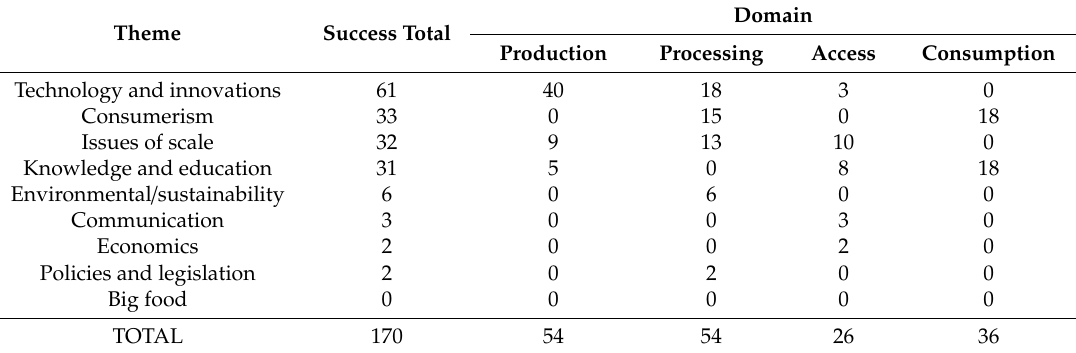
Table 3. Successes associated with transitioning towards a sustainable food system, across domains and themes determined by